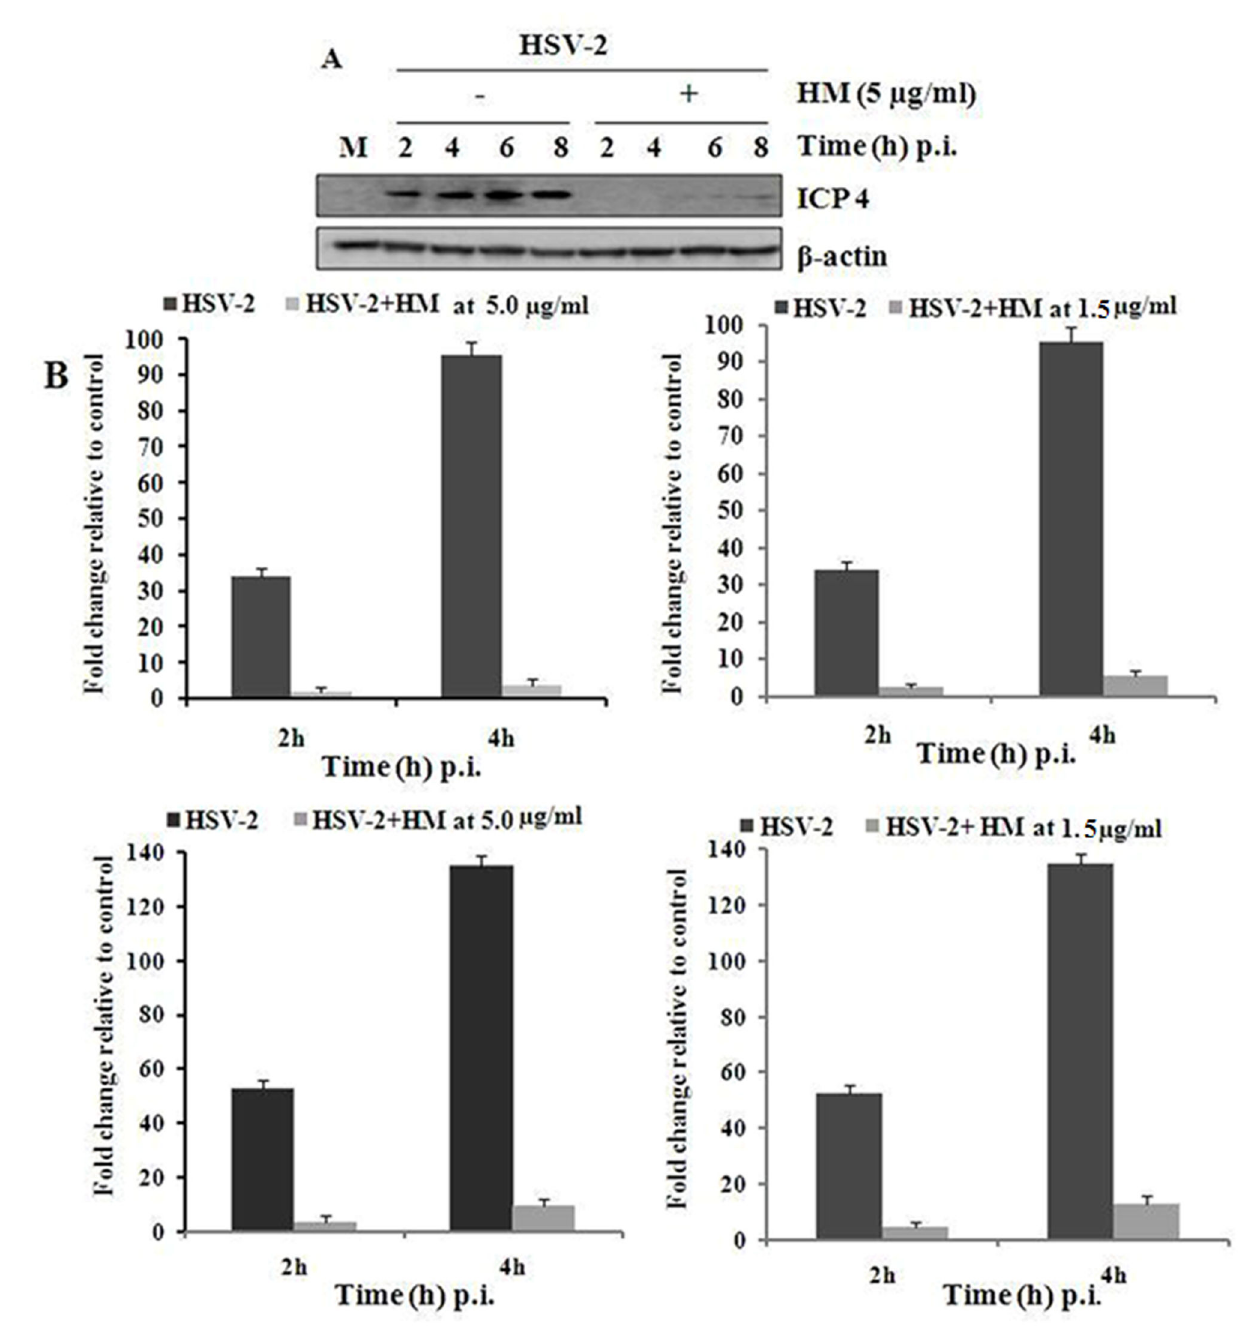
Figure 4. Effect of HM on IE gene expression. [A] Western blot analysis : 40 µg of protein sample from whole cell extracts were separated by SDS-PAGE, blotted to nitrocellulose, and filters were incubated with monoclonal anti-ICP4 or polyclonal anti-β actin antibody followed by decoration with peroxidase-labelled anti-rabbit polyclonal antibodies, respectively and visualized using ECL Western blot detection kit. [B] Quantitative real time PCR : HSV-2G (5 moi) infected cells were treated with HM (5.0 µg/ml) for 2 and 4 h. After incubation at 37°C RNA was isolated and subjected to cDNA synthesis. Then quantitative real-time PCR was performed with these products by using SYBR Green PCR Master Mix. PCRs were amplified with the cycling conditions of: 95°C for 10 min and 40 cycles (15 s at 95°C, then 60 s at 60°C).